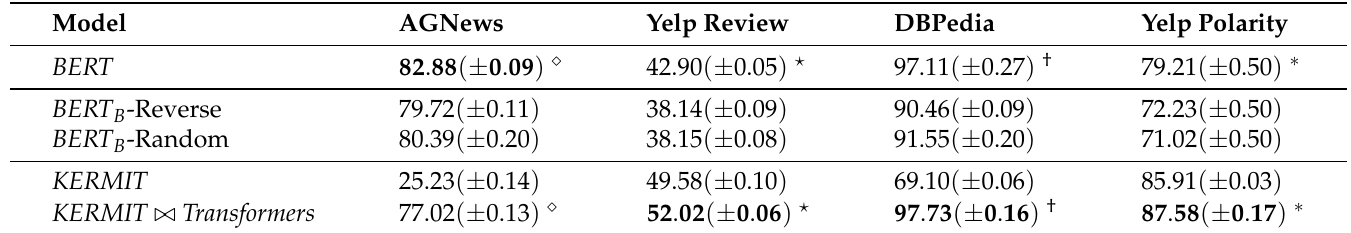
Table 2. Universal Setting —Average accuracy and standard deviation on four text classification tasks. Results derive from 5 runs. (cid:63) , , † and indicate a statistically significant difference between two (cid:5) ∗ results with a 95% confidence level with the sign